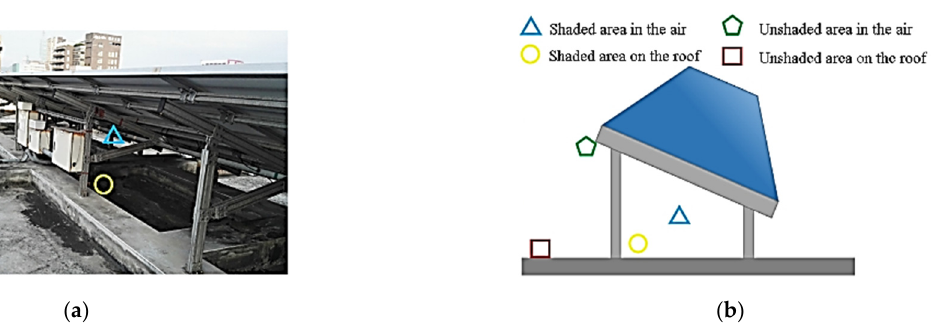
Table 1. Sensing positions on the photovoltaic roof.